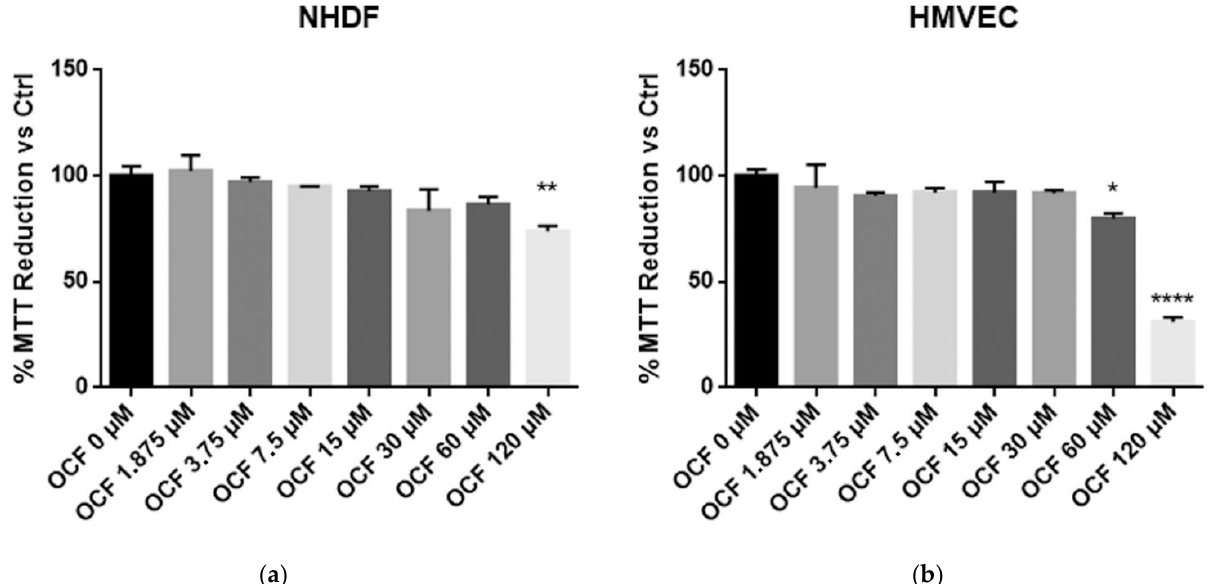
Figure 1. MTT assay on normal cells. NHDF (Neonatal Human Dermal Fibroblasts) ( a ) and HMVEC (Human Microvascular Endothelial Cells) ( b ) are non-transformed cell cultures and these were used in order to test their vitality using an OCF dose-dependent treatment through a MTT test. Data are presented as mean ± SD; * p < 0.05; ** p < 0.01; **** p < 0.0001 (One-way ANOVA Dunnett’s multiple comparison test).